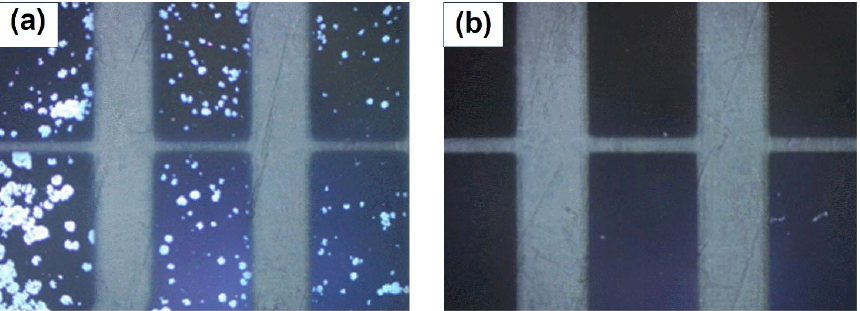
Figure 2. Optical images of the Cr/Al/Cr/TiN anodes ( a ) without and ( b ) with TiN after being stored in the ambient for 100 h.